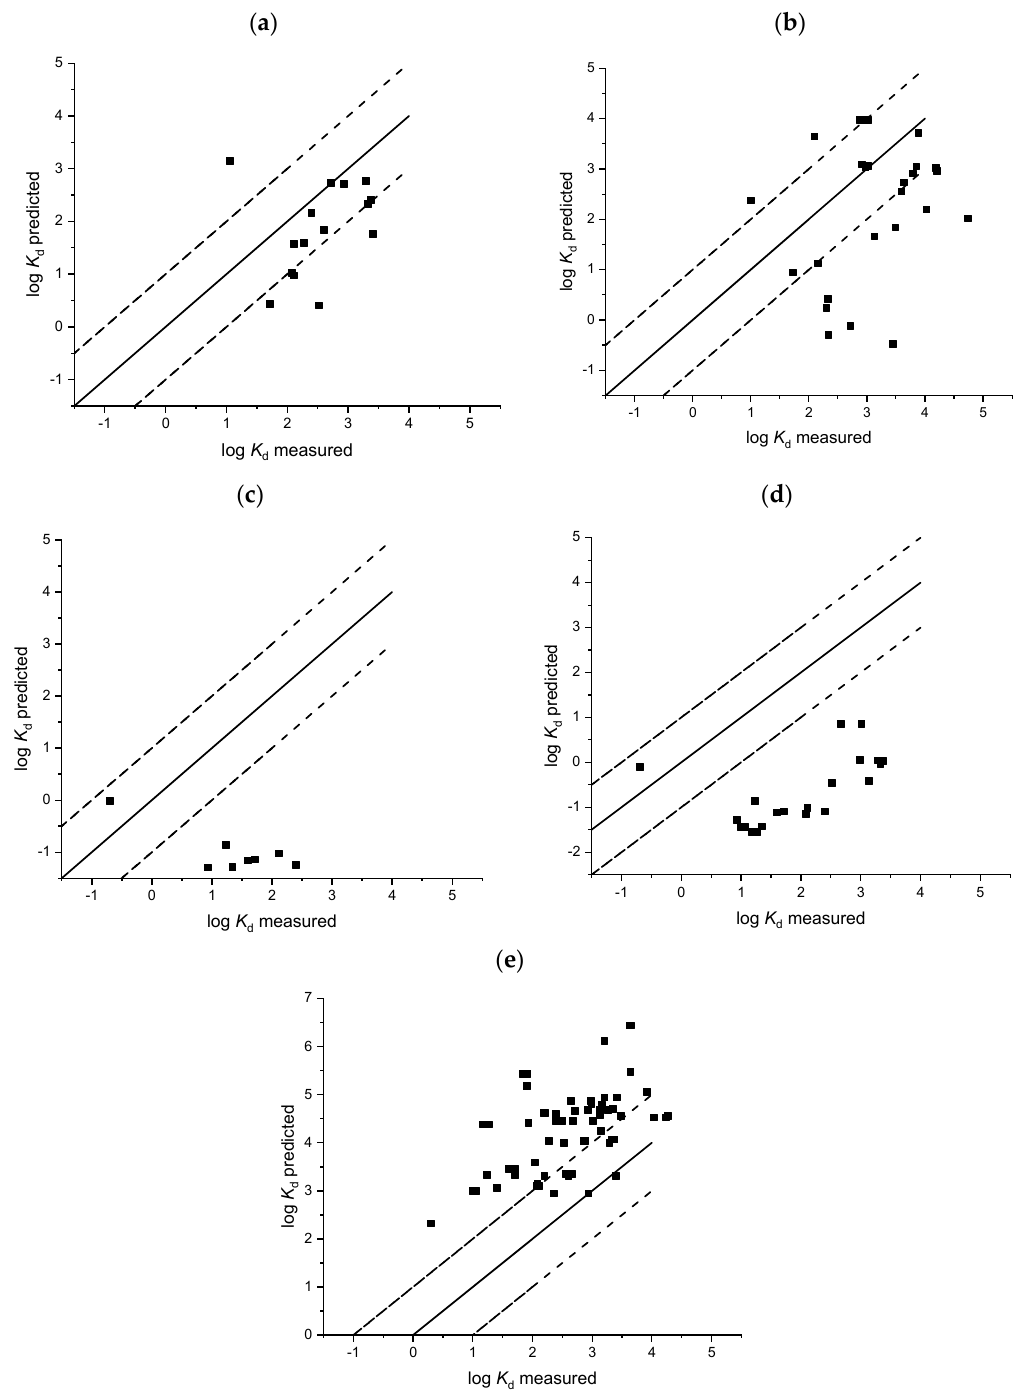
Figure 4. Comparison of predicted and measured sludge sorption coefficients (log K d ), Franco et al. [33] acids ( a ); Franco et al. [33] bases ( b ); Sathymoorthy and Ramsburg [32] ionised acids ( c ); Sathymoorthy and Ramsburg [32] acids ( d ); Berthod et al. [34] ( e ).